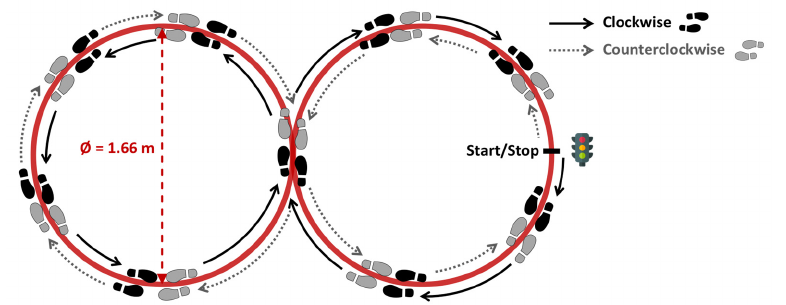
Figure 1. The Figure-of-8 Walk Test, adapted from [18].